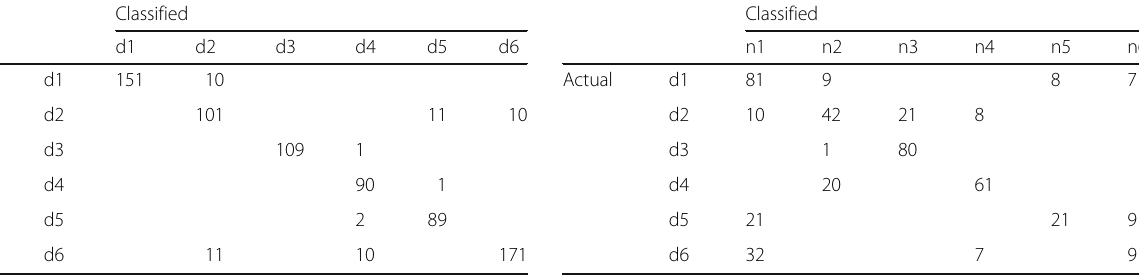
Table 1 Confusion matrix for the visual image classifier